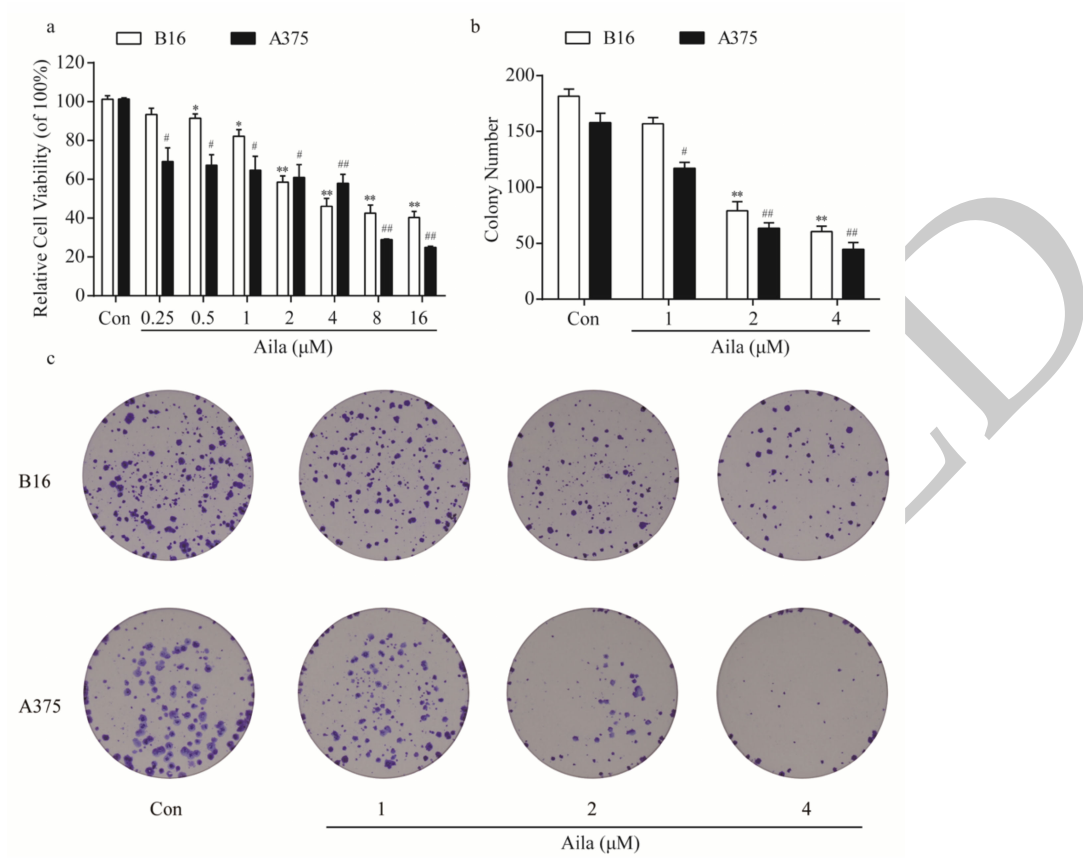
Figure 2. Ailanthone inhibits cell proliferation and cell colony formation in melanoma B16 and A375 cells. ( a ) After treatment with different concentrations of ailanthone (0.25, 0.5, 1, 2, 4, 8, and 16 µ M) for 24 h, the cell viabilities of B16 and A375 cells were determined using the cell counting kit-8 assay. ( b ) Statistical analysis of the number of cell colonies in ailanthone-treated B16 and A375 cells. ( c ) The cell colonies were stained with crystal violet and observed under an inverted microscope. The data are presented as the mean ± SD ( n = 3). * p < 0.05, ** p < 0.01 compared with the control B16 cells. # p < 0.05, ## p < 0.01 compared with the control A375